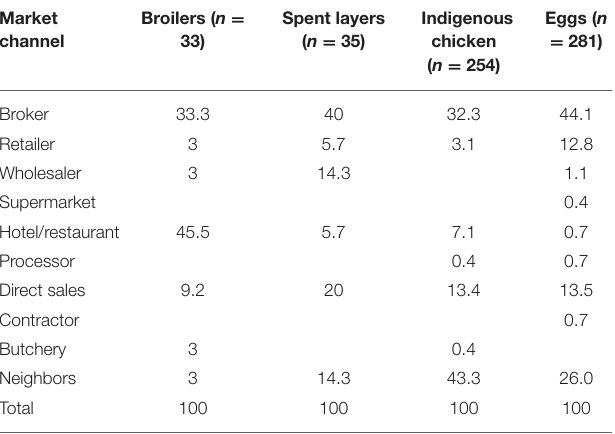
TABLE 3 | Poultry and poultry products marketing channels in Thika and Kisumu, 2016. Market channel